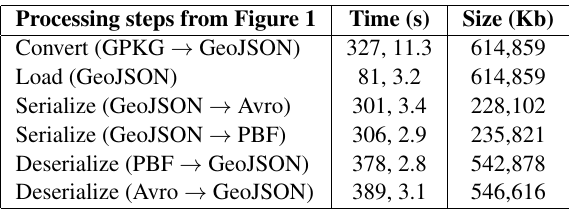
Table 1. Results of Experiment 1 using the GPKG dataset: mean and standard deviation of the time required for each processing step and size of the resulting